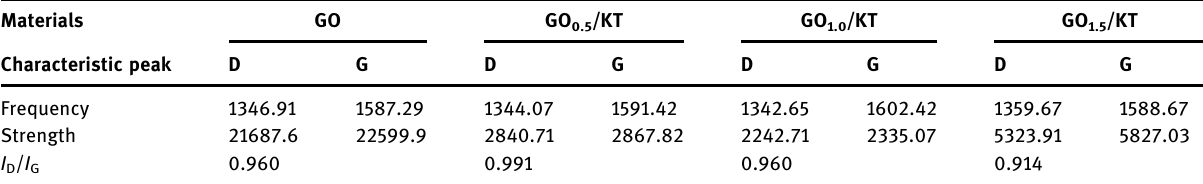
Table 8: Characteristic peaks of Raman spectra of GO and modi fi ed tourmaline Materials